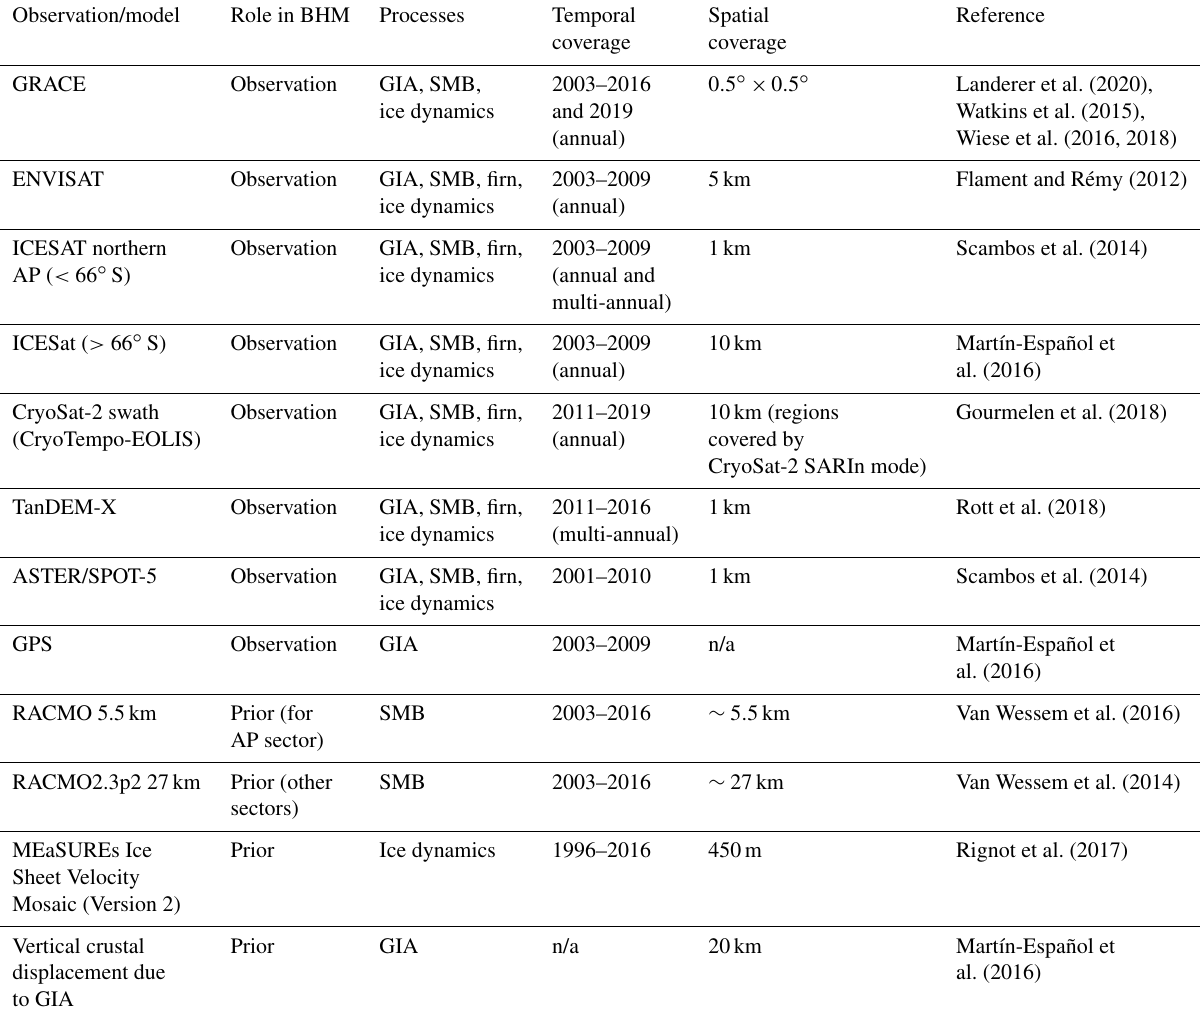
Table 1. Summary of observations and prior auxiliary datasets used in this study, including their spatio-temporal coverage and latent processes they